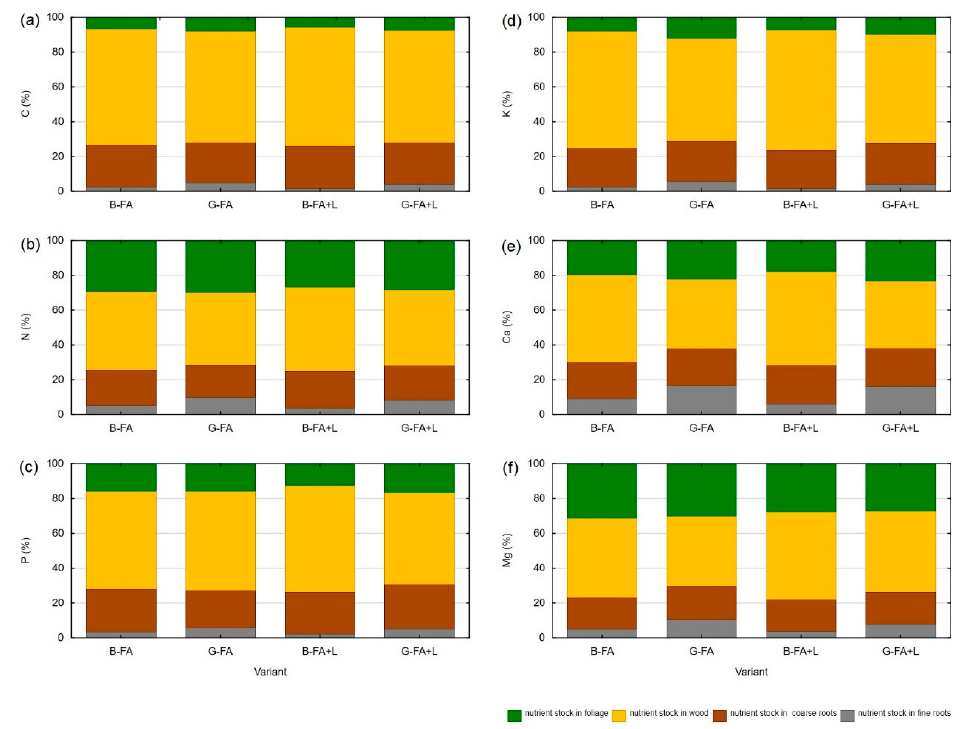
Figure 5. The share of nutrient stocks in individual biomass components in total stocks: ( a ) C, ( b ) N, ( c ) P, ( d ) K, ( e ) Ca, and ( f ) Mg. ( c ) P, ( d ) K, ( e ) Ca, and ( f )